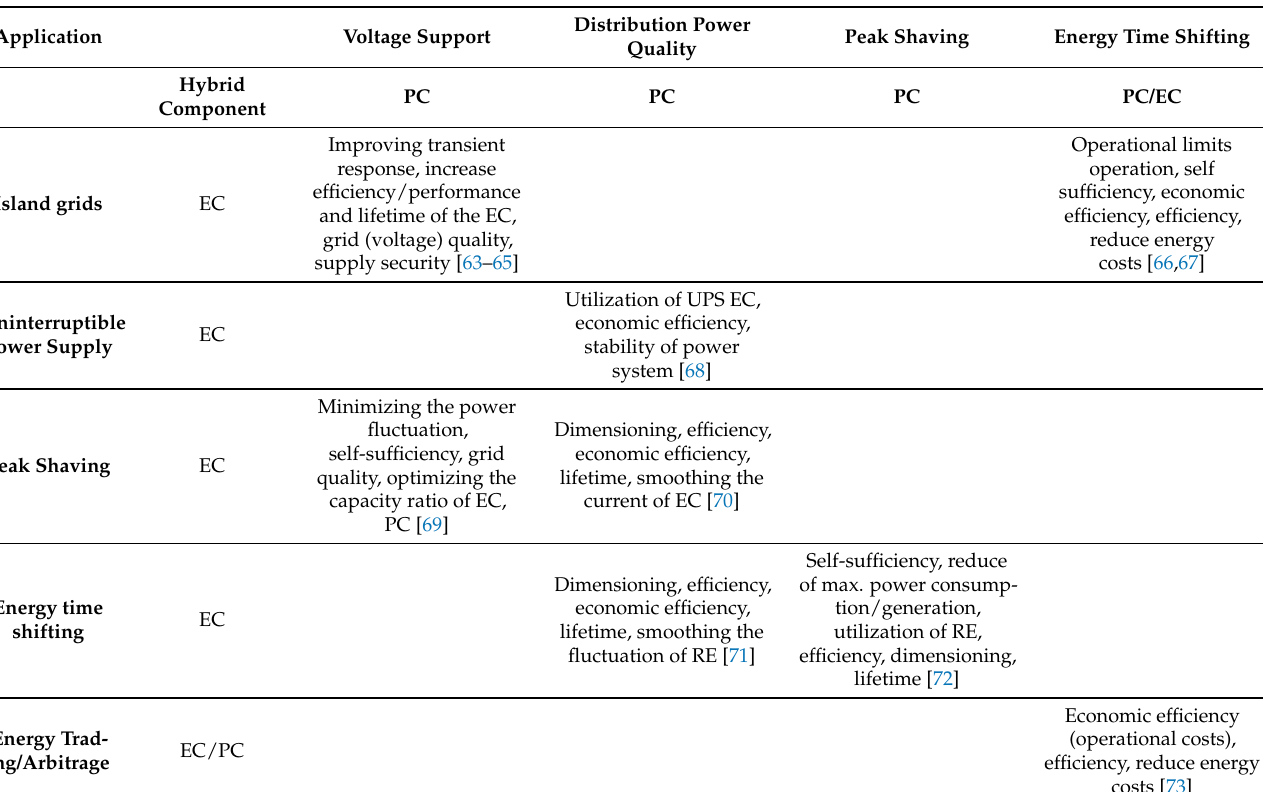
Table 5. Map of optimization parameters and EMS goals for the hybrid storage application categories (PC: Power Component; EC: Energy